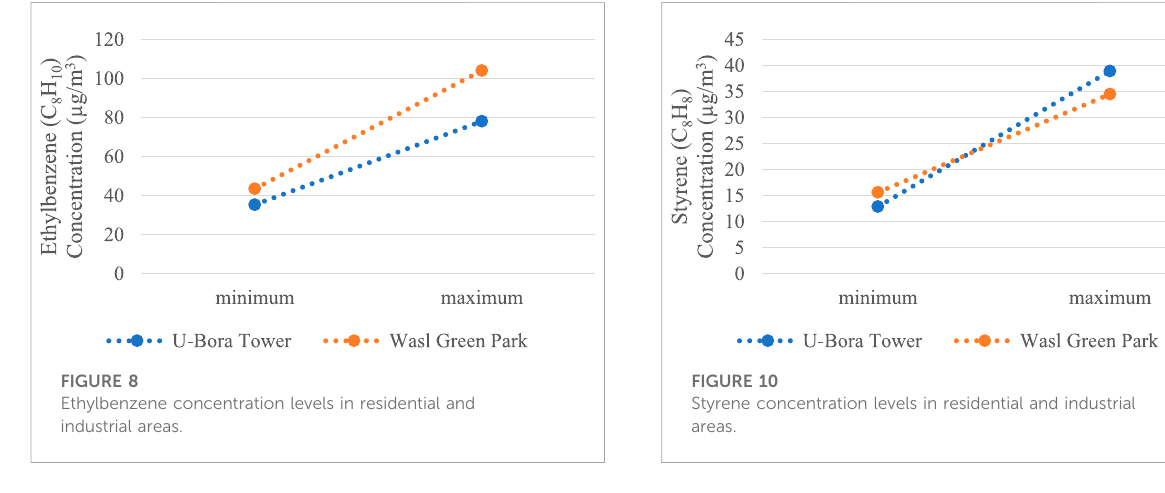
FIGURE 8 Ethylbenzene concentration levels in residential and industrial areas.